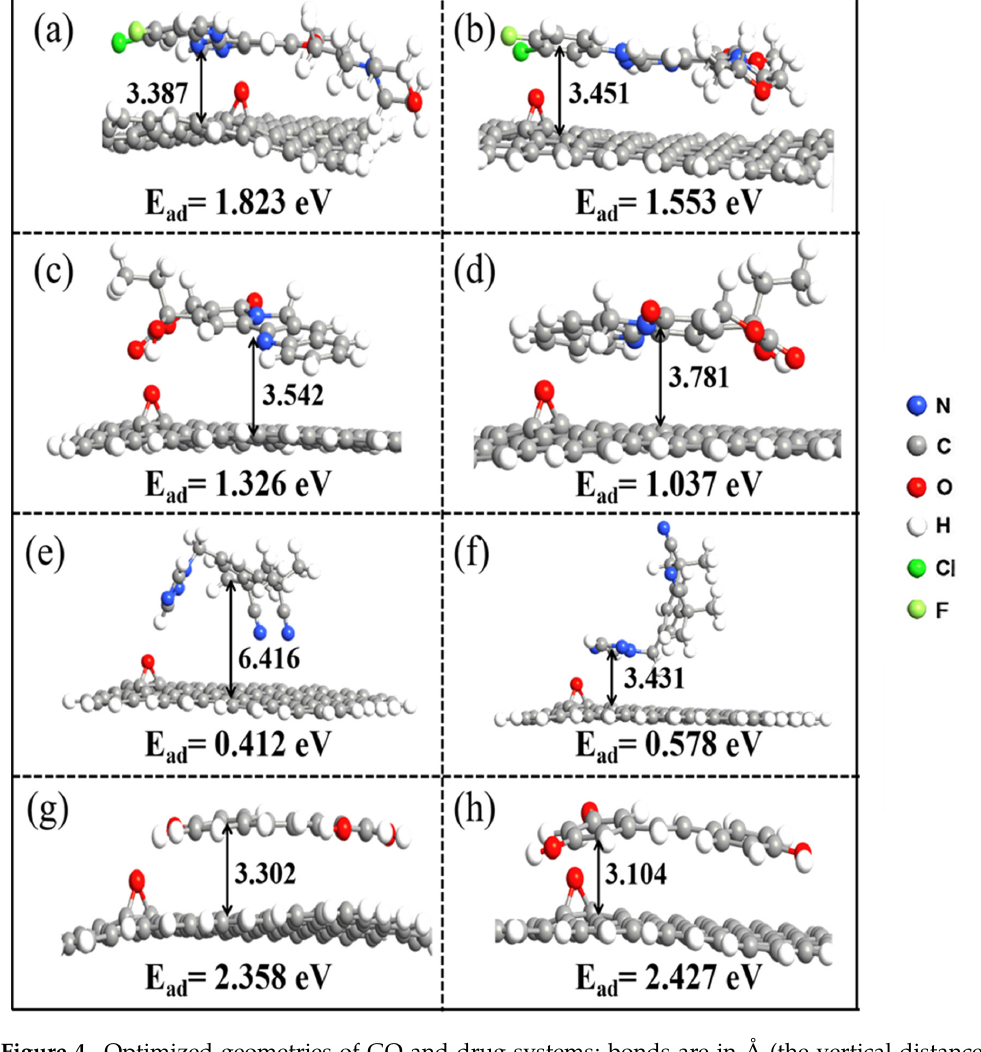
Figure 4. Optimized geometries of GO and drug systems; bonds are in Å (the vertical distance refers to the distance between the centroid of benzene of different drugs to the carbon plane of GO). ( a ) GO-Gefi-2; ( b ) GO-Gefi-4; ( c ) GO-Camptothecin-1; ( d ) GO-Camptothecin-4; ( e ) GO-Anas-1; ( f ) GO-Anas-2; ( g ) GO-Res-1; ( h ) GO-Res-2. Figure 5a shows the RMSD result for the adsorption of four drug molecules on GO, from which it can be seen that all the systems reach the equilibrium state in a short time.